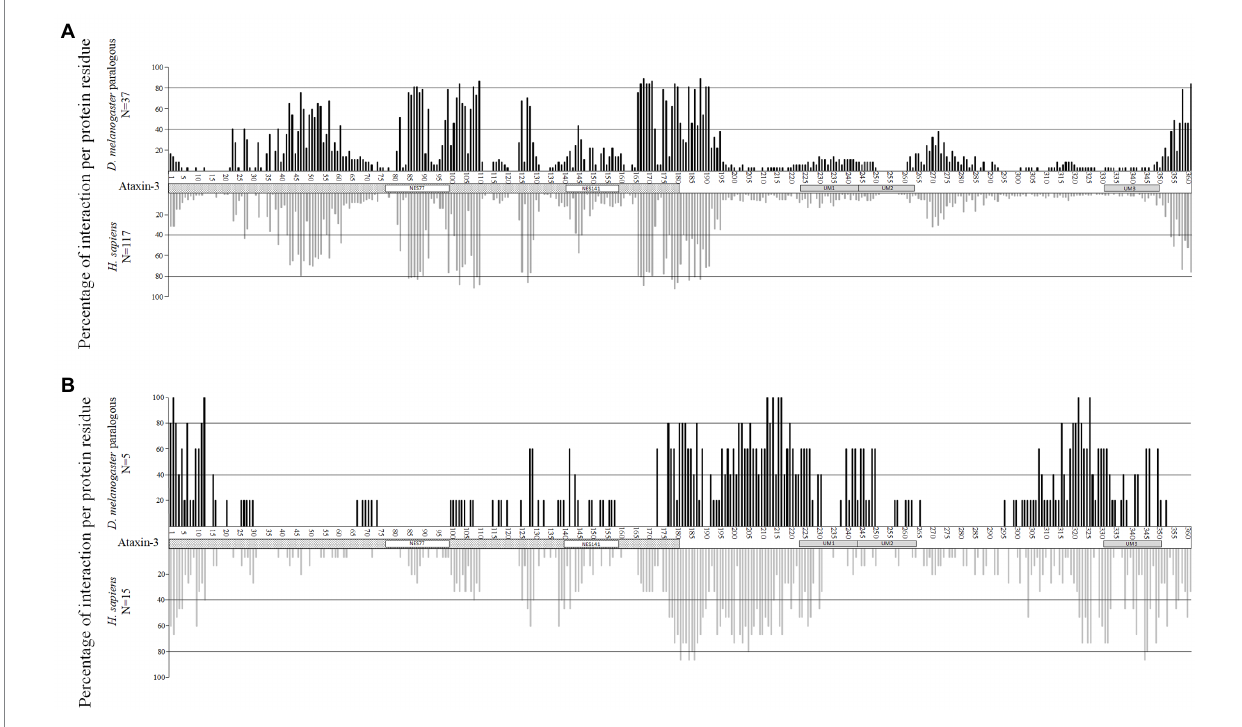
FIGURE 3 Percentage of interaction per protein residue at the ataxin-3 for fly paralogous (upper panel, in black) and human interactors (lower panel, in gray) that show most of the interactions at the JD (A) and those that interact mostly at the C- terminal region (B) . The JD is assigned as a dotted box, while the NES77 and NES141 regions are marked with white boxes. UIM regions are also assigned with gray